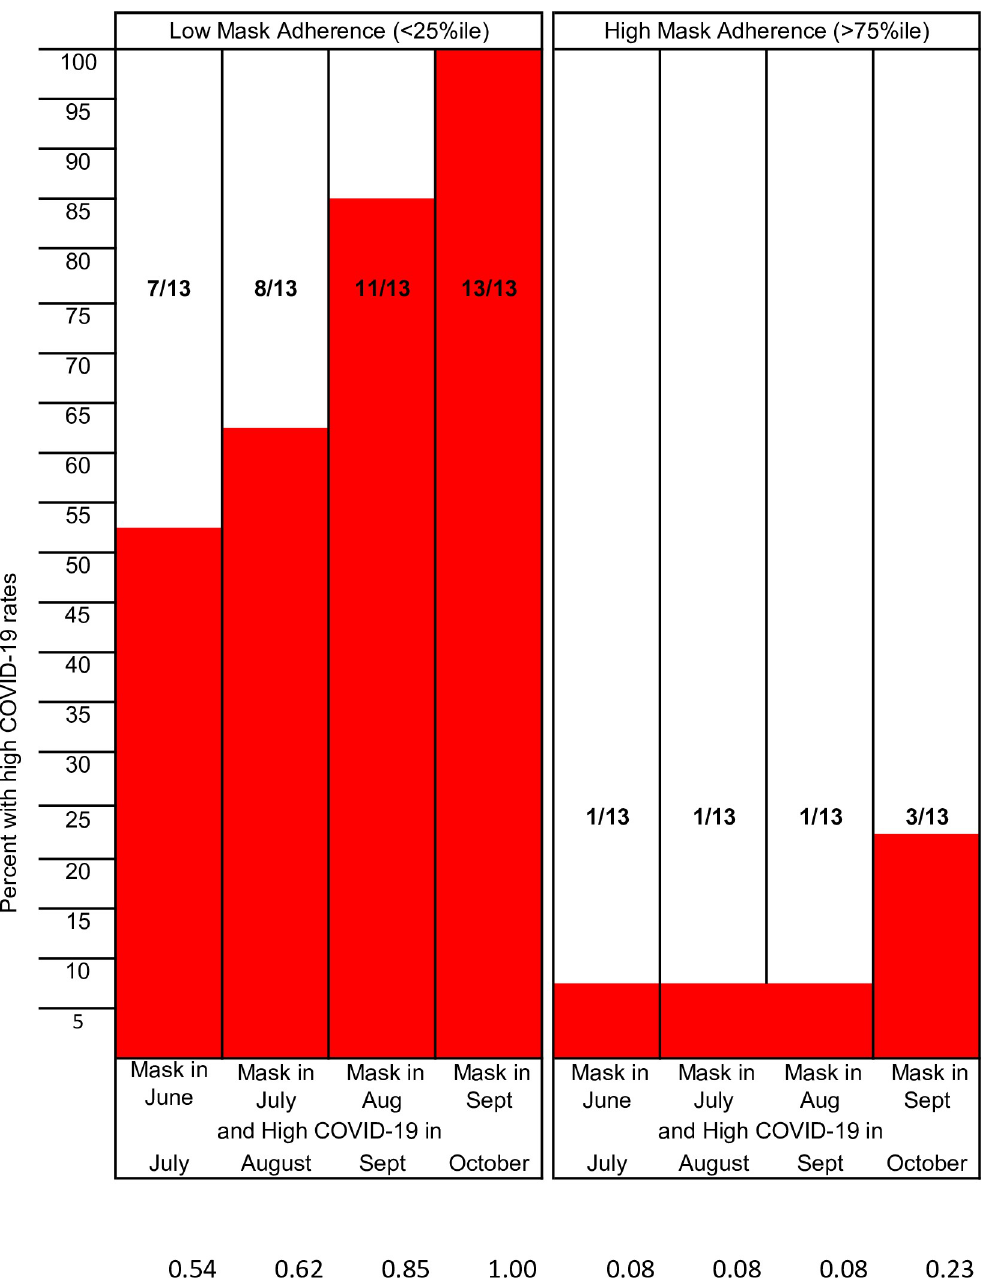
Fig 1. Proportion of states with high COVID-19 rates among those in the low and high mask adherence quartiles in the preceding